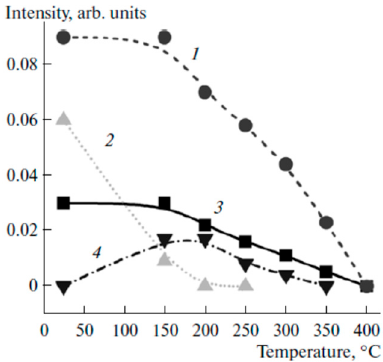
Figure 12. The temperature dependence of the stability of ethylene glycol complexes adsorbed on the reduced Ag/P 2 O 5 /SiO 2 : (1) catalyst: (1) H-bonded POH groups (3500–3600 cm − 1 ), (2) H-bonded OH groups of ethylene glycol (3220 cm − 1 ), (3) CH groups of ethylene glycol (2960 cm − 1 ), and (4) free OH groups (3735 cm − 1 ). Reprinted with permission from reference [88]. Copyright 2013 Springer.